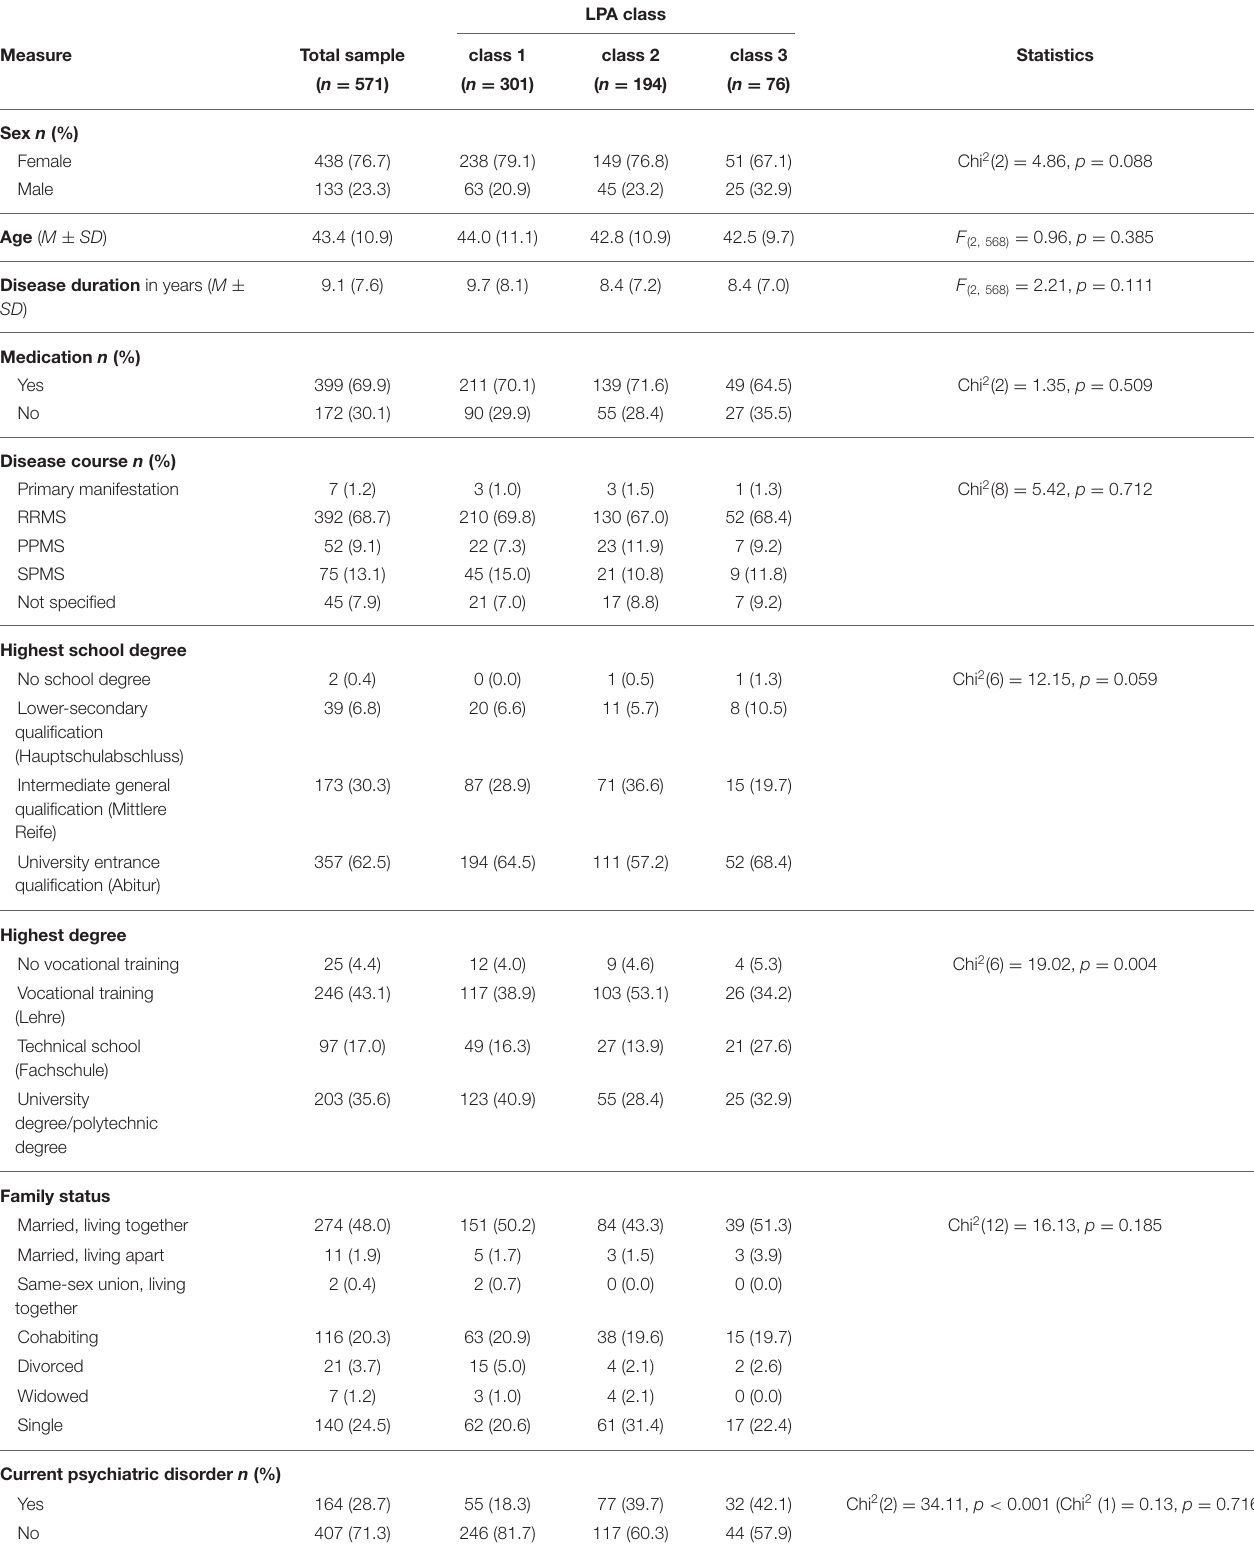
TABLE 3 | Socio-demographic and clinical data (1) of the total sample, (2) and separated by LPA